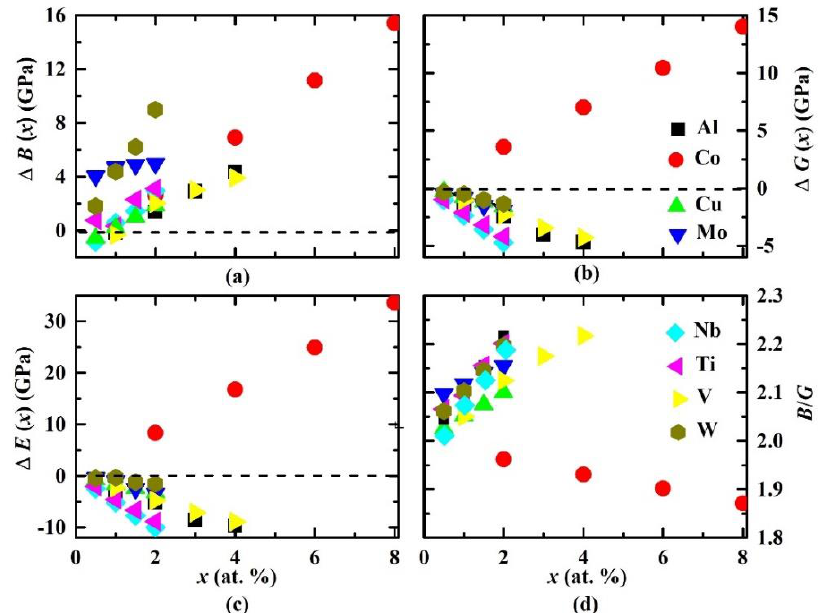
Figure 5. Theoretical changes in polycrystalline elastic constants ( a ) ∆ B ( x ) , ( b ) ∆ G ( x ) , and ( c ) ∆ E ( x ) of paramagnetic fcc Fe 0.6 − x Cr 0.2 Ni 0.2 M x (M = Al, Co, Cu, Mo, Nb, Ti, V, and W; 0 ≤ x ≤ 0.08) quaternary alloys relative to those of the paramagnetic fcc Fe 0.6 Cr 0.2 Ni 0.2 ternary alloy, and ( d ) the B / G ratio as a function of atomic concentration x .